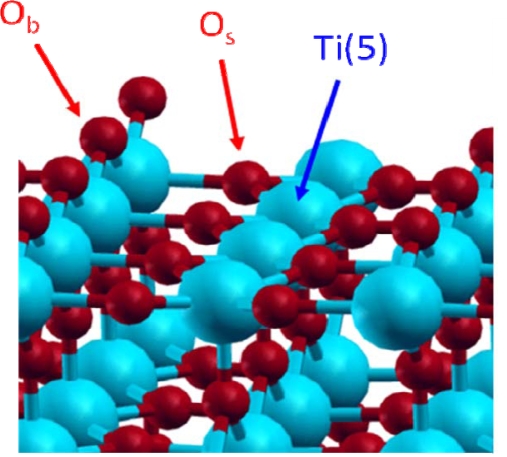
Dry TiO2 rutile (110) face.